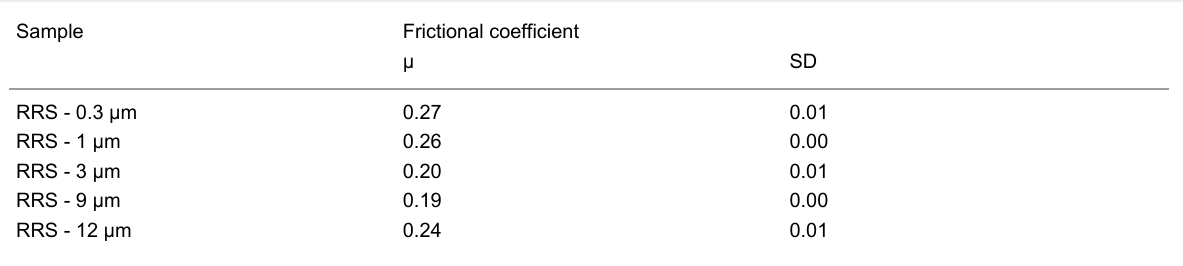
Table 3: Mean frictional coefficients of randomly-rough surfaces – RRS determined by zero-frequency of the FFTs curve.